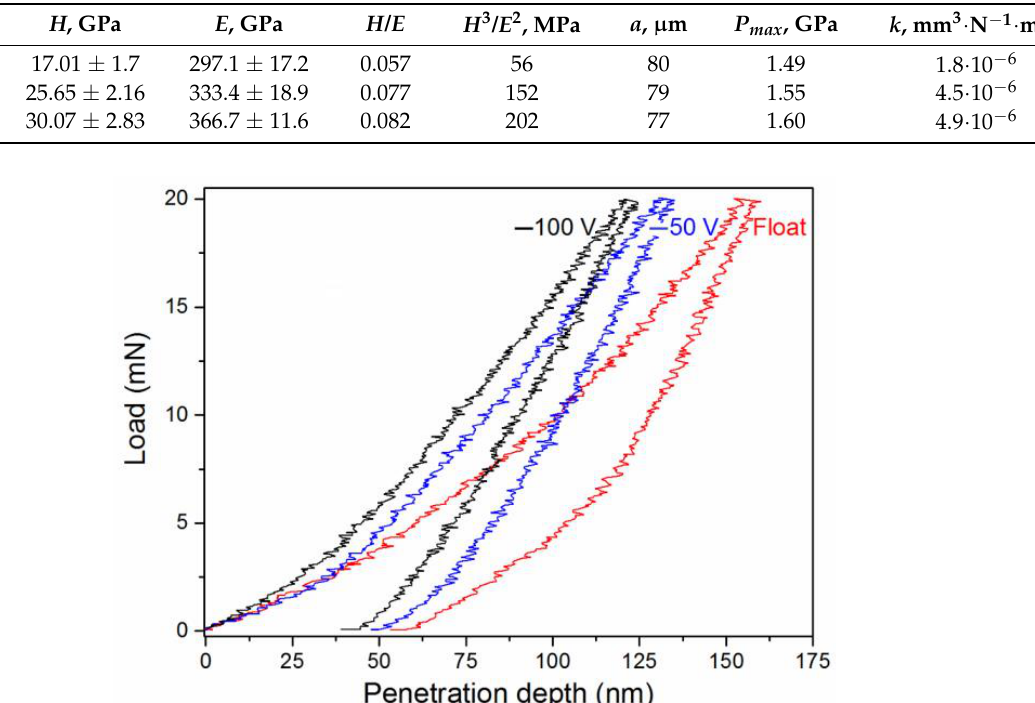
Figure 5. Loading–unloading curves of nanoindentation for the TiAlN coating deposited by the Al Figure 5. Loading – unloading curves of nanoindentation for the TiAlN coating deposited by the Al magnetron at 30 W of power and different substrate bias magnetron at 30 W of power and different substrate bias voltages.